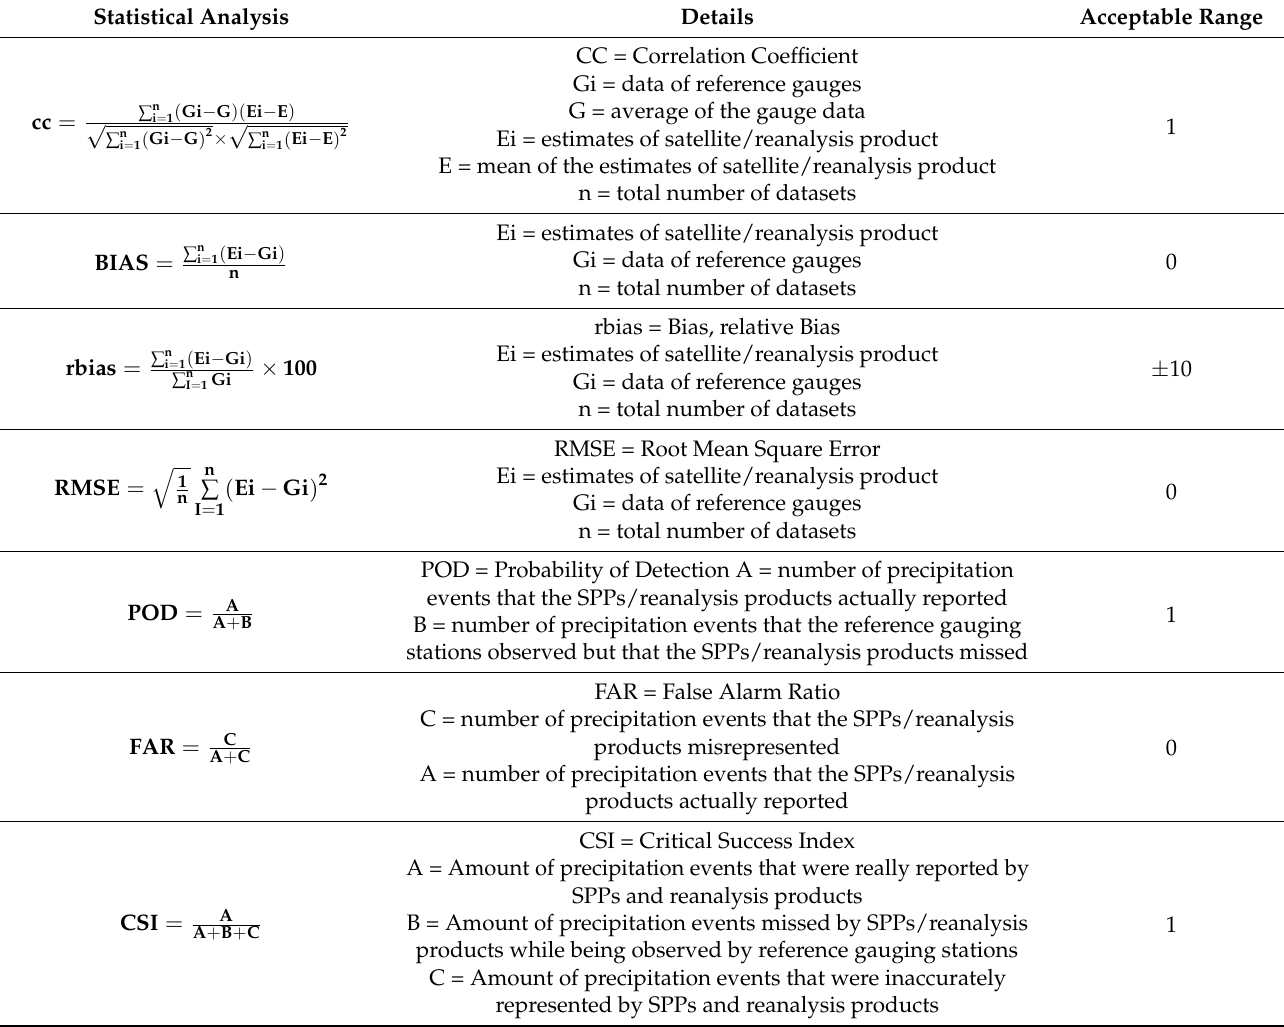
Table 2. Statistical analysis equations with their acceptable